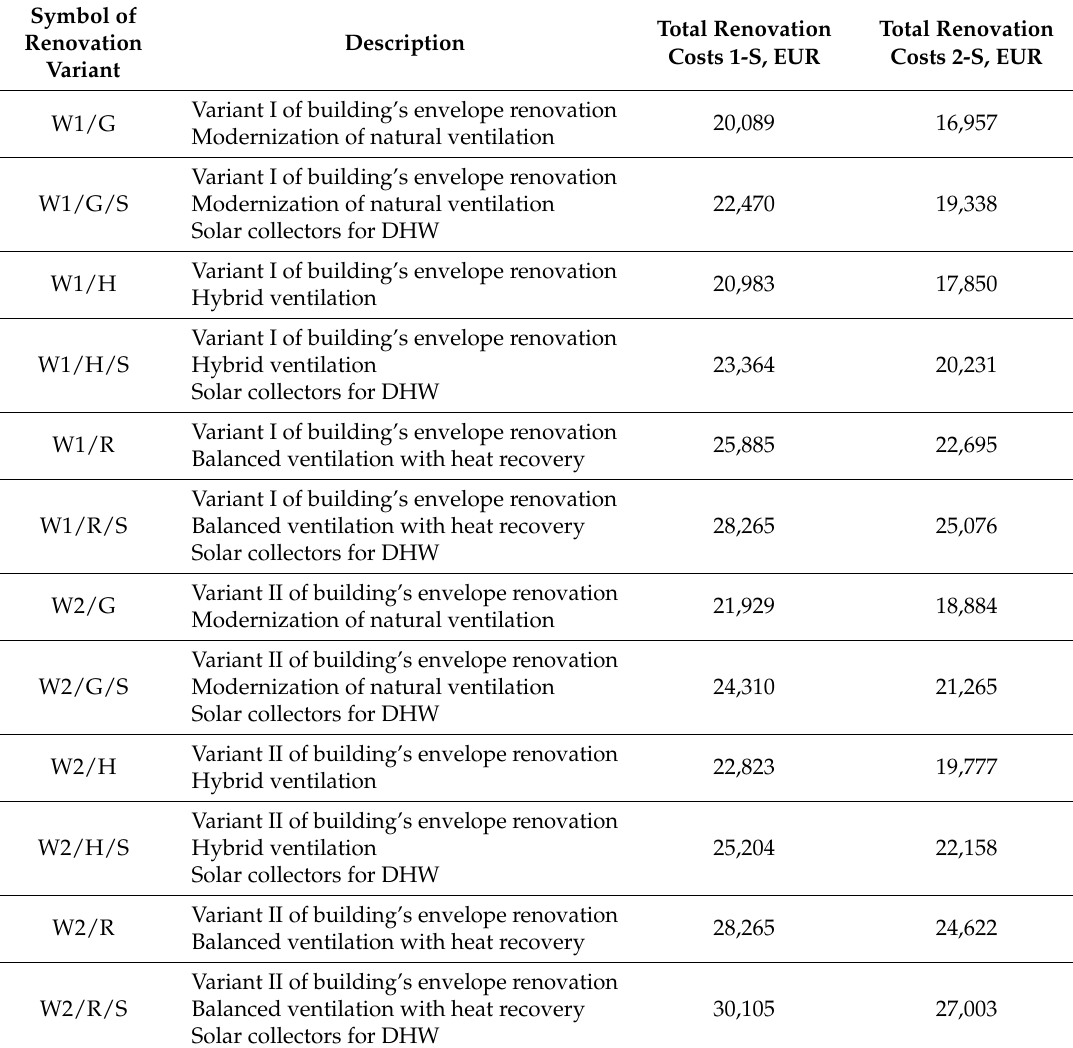
Table 16. Renovation variants matrix and